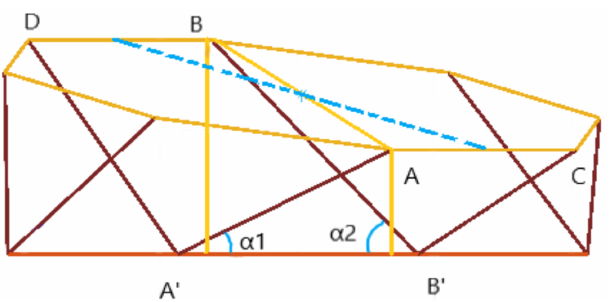
Figure 7. Side view of a bending one-layer twisted tower with offset angles α 1 and α 2